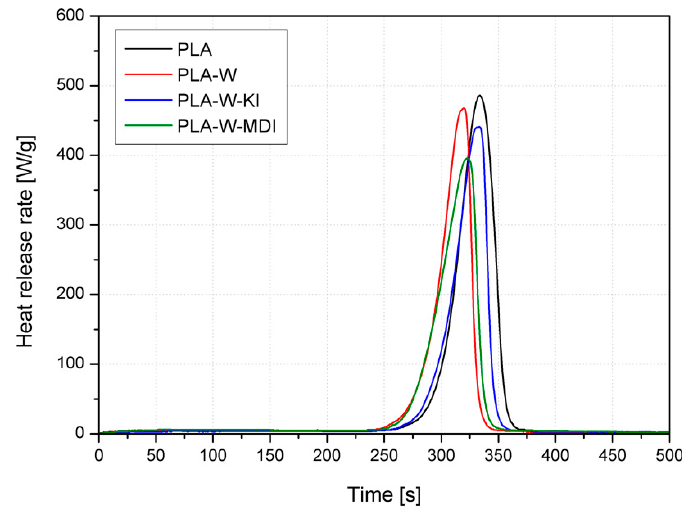
Figure 15. Results of PCFC of PLA and PLA composites.